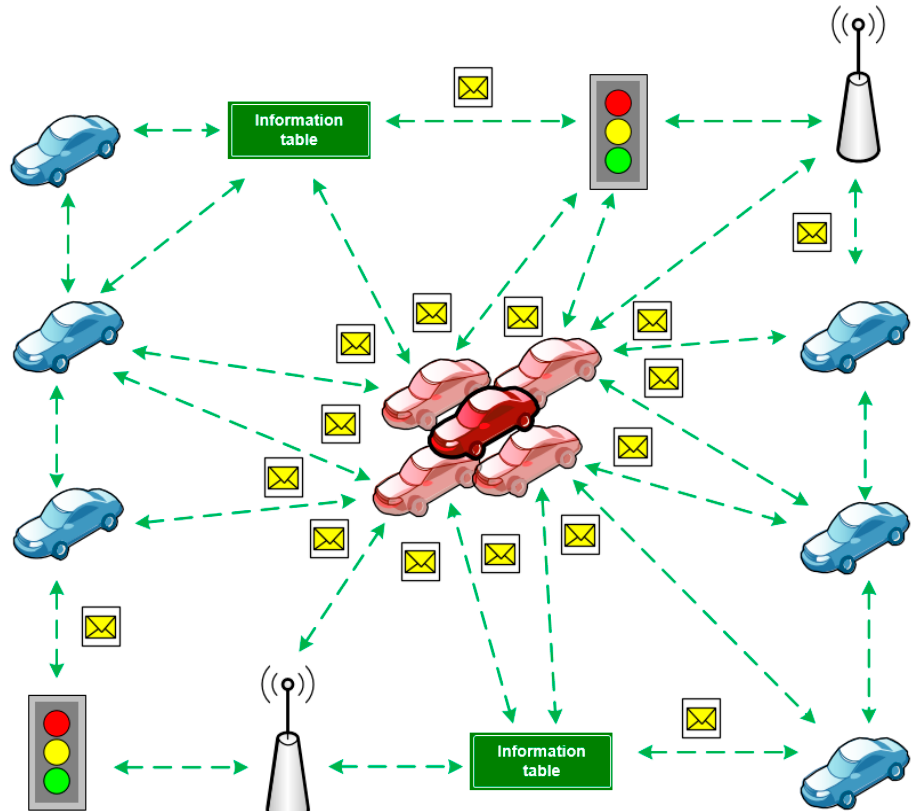
Figure 9. The Sybil attack case.